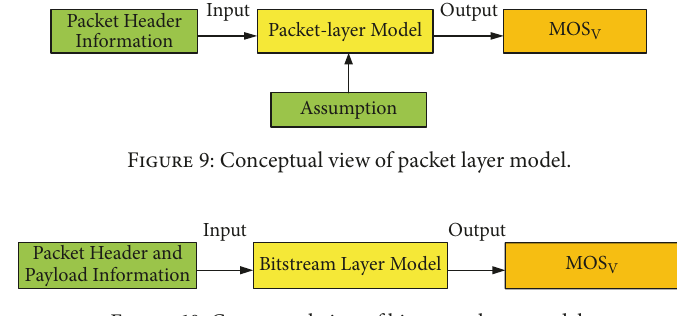
Figure 10: Conceptual view of bitstream layer model.